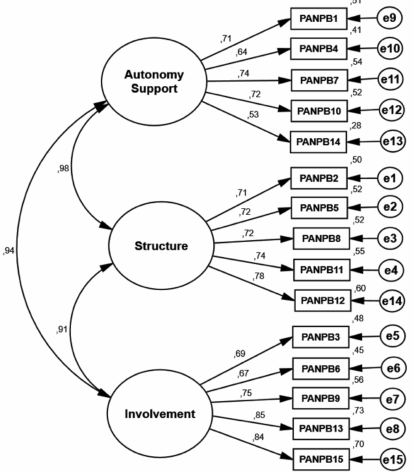
Figure 2. Standardized individual parameters (covariance factors. factorial weights and measurement errors), all of which were significant in the measurement model (PESSp - three factors/15 items) for the Portuguese validation sample